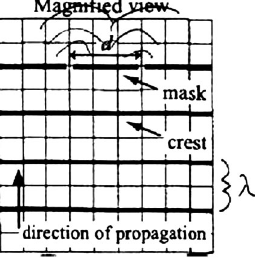
FIG. 4. A sketch given by a student in response to the slit separation task. The student correctly identified the wavelength on the diagram and yet failed to determine the distance between the slits in terms of the